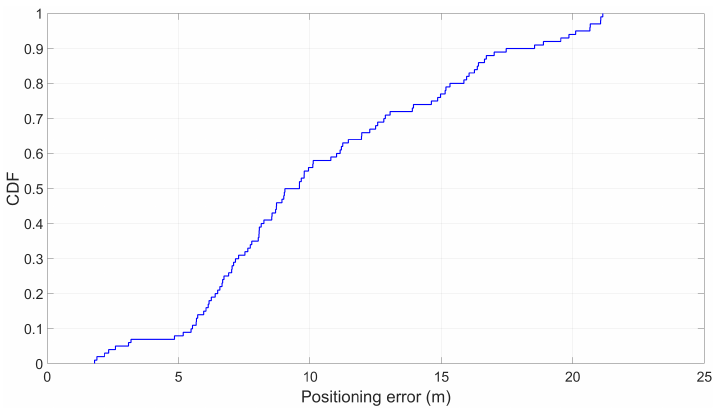
Figure 18. The positioning error using open space